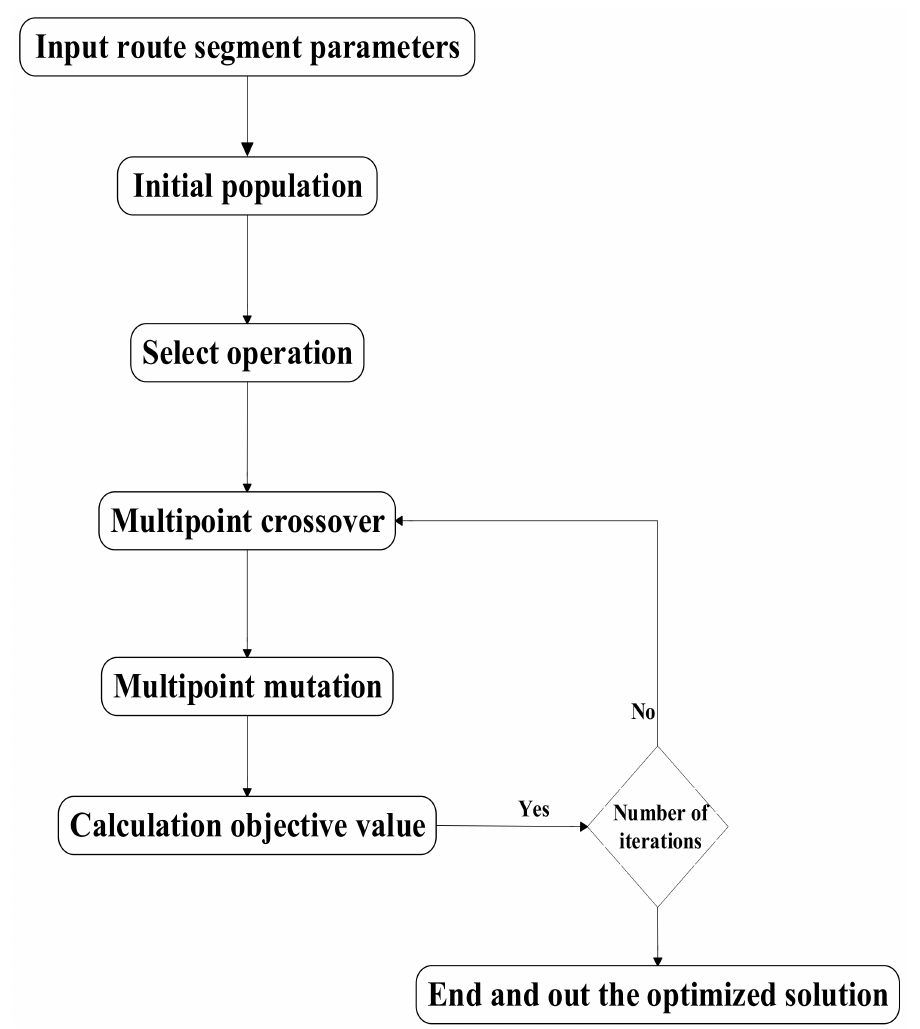
Figure 1. The flowchart of the improved genetic